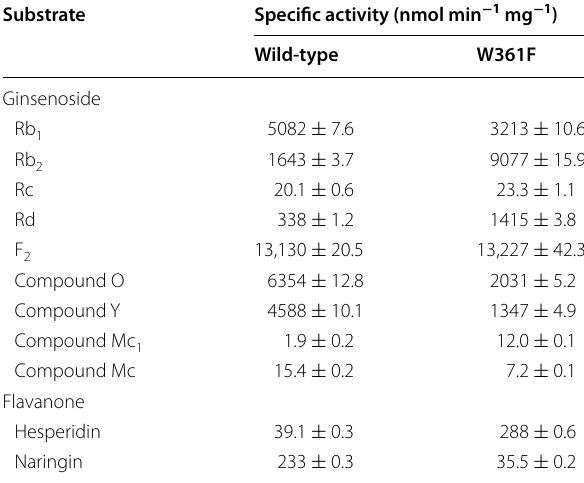
Table 1 Specific activities of the wild-type and W361F var- iant enzymes for ginsenosides and flavanones Substrate